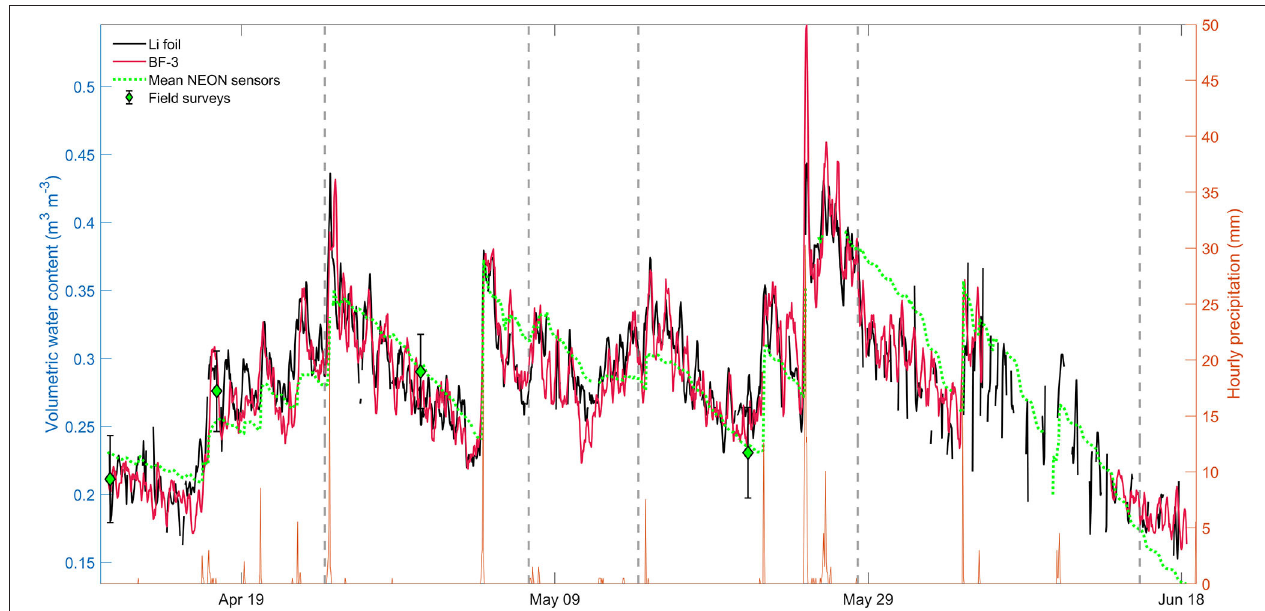
FIGURE 7 | Estimated field-average volumetric water content using a Li foil cosmic ray neutron probe (CRNP), and a BF-3 CRNP, an array of five in situ sensors from the NEON network, and four field surveys in which water content was measured using a calibrated hand-held soil water reflectometer. The data from the field surveys were used for calibration of the CRNPs. Vertical dashed lines indicate the start of 12h periods during which data from the array of NEON sensors were also included in the CRNP calibration to cover a wider range of volumetric water content. The lines for the CRNPs represent the 11h moving Savitzky-Golay filter (polynomial degree